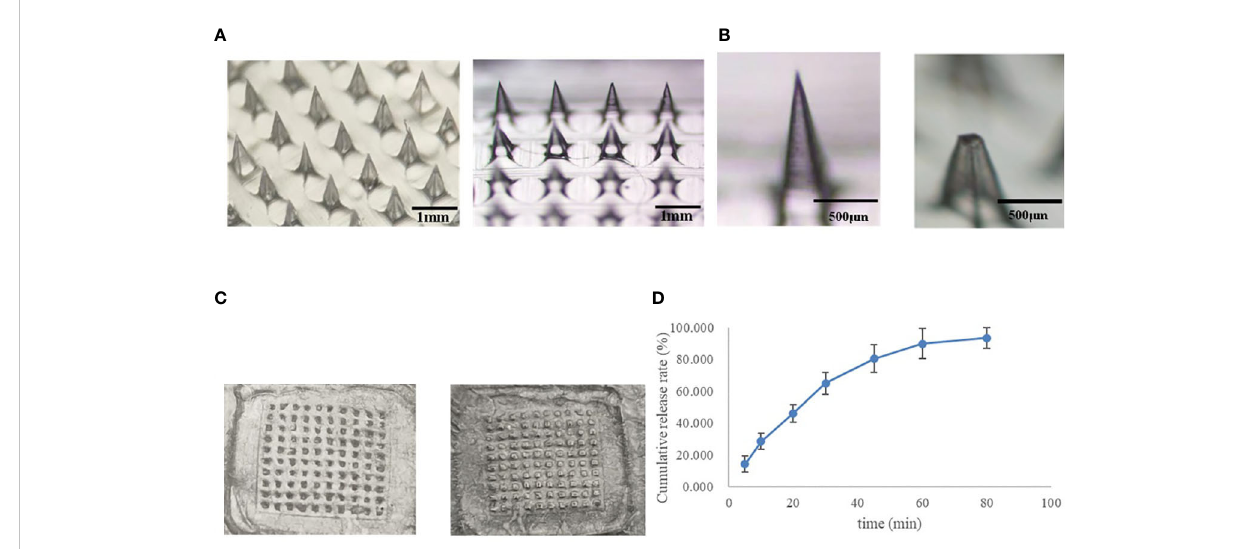
FIGURE 3 Microneedle characterization results (A) . Microneedle, (B) Appearance of microneedle under microscope (Left: 800 m m. Right: 696 ± 2.5 m m), (C) Micropuncture into 4 layers Para fi lm Ⓡ membrane (Left: front, right: reverse), (D) Microneedle release in vitro (n=3)).